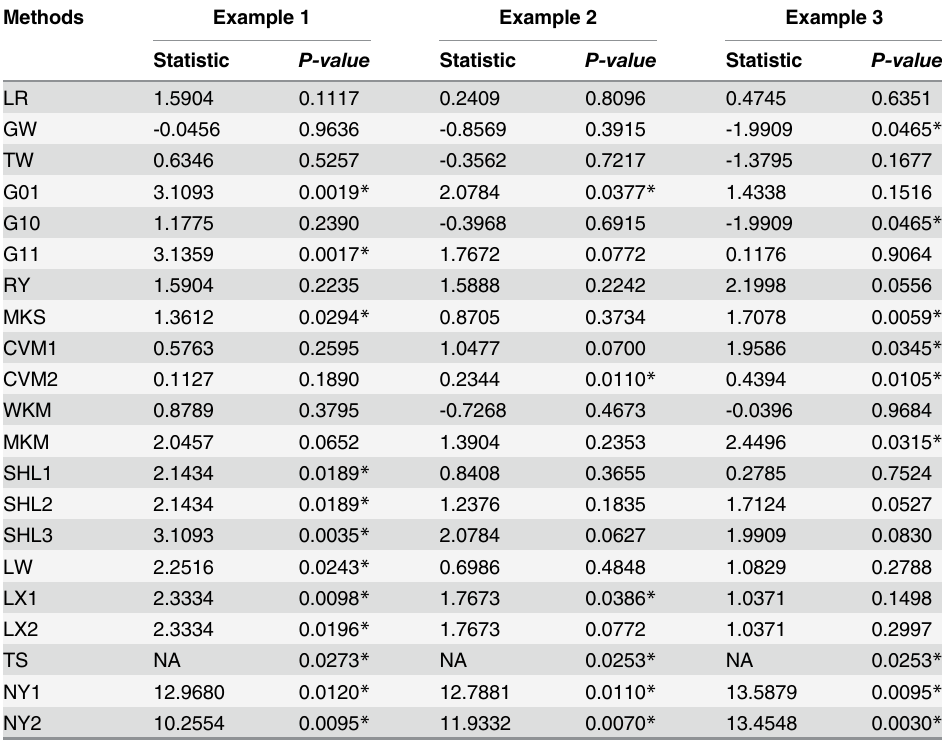
Table 6. The results of various procedures for three